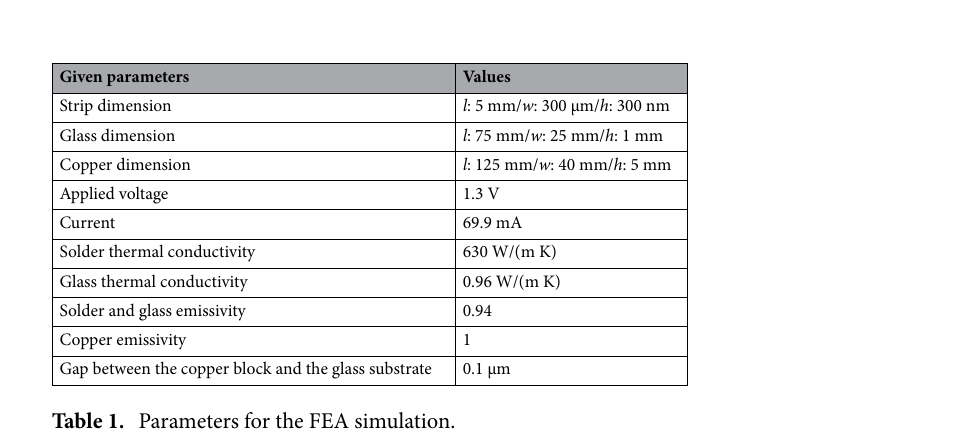
Table 1. Parameters for the FEA